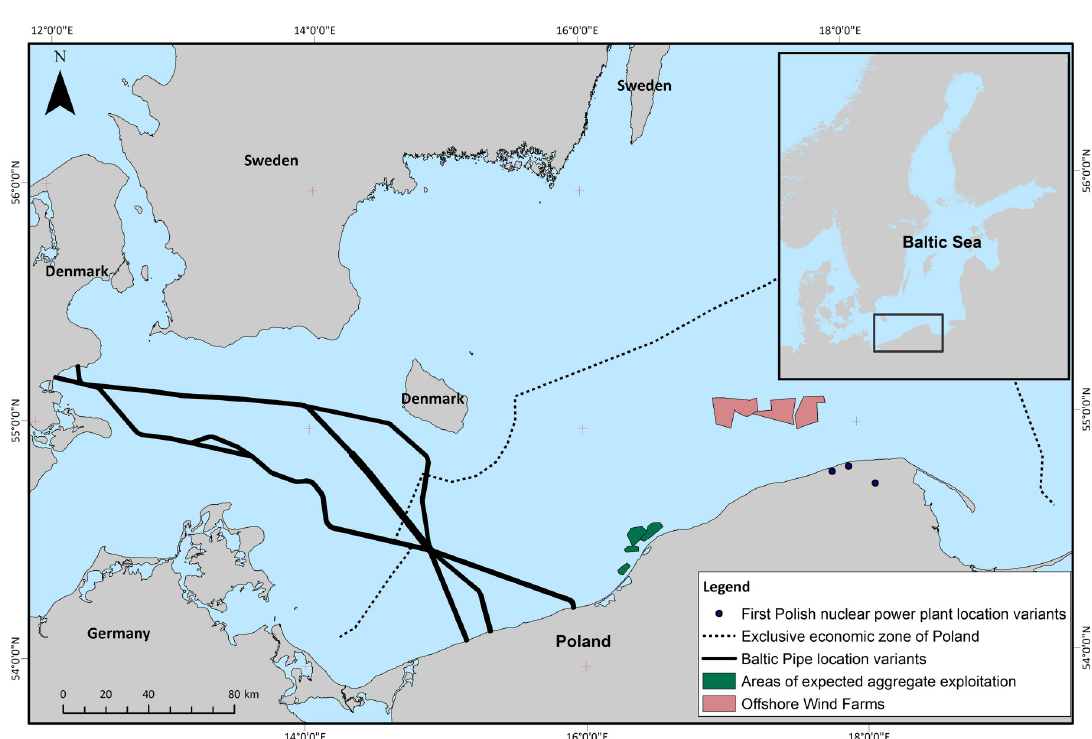
Fig 1. Map with marked areas for offshore investments where Maritime Institute and MEWO conducted pre-investment research used in the documentation review for this paper.